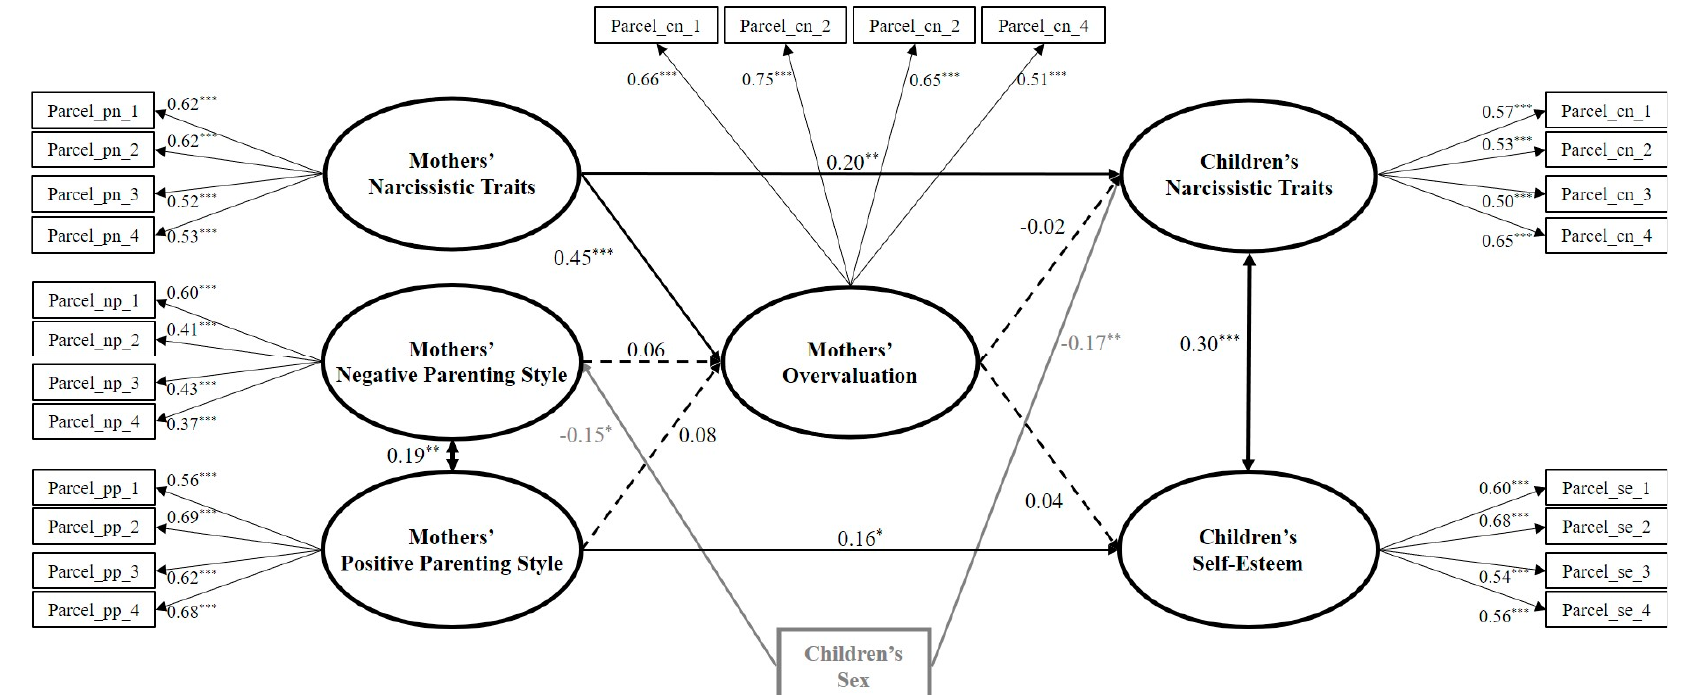
Figure 3. Estimated structural equation model for the best fitting mediation model among the mother–child dyads. N = 494. Standardized regression coefficients (betas) are shown. The measurement part of the model (including the parcels and factor loadings) is presented in black. The key study latent variables and their related paths are presented in bold black. Sex, as the control variable, and its related paths are presented in bold gray. Solid lines represent significant paths and dashed lines represent non-significant paths. For better visualization, residuals and non-significant covariances are not shown. * p < 0.05, ** p < 0.01, *** p < 0.001.